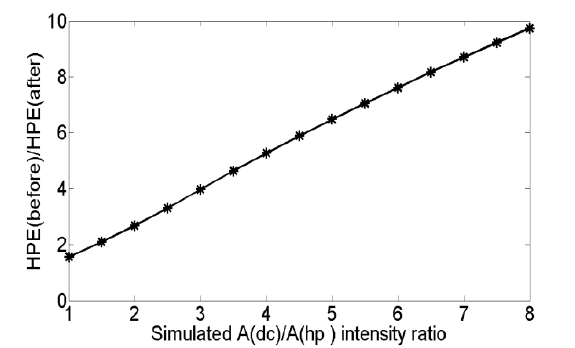
/HPE under different before after